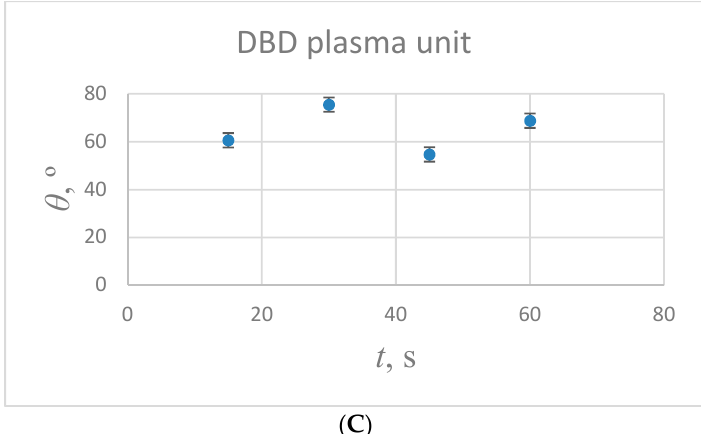
Figure 4. Impact of the dependence of the equilibrium apparent contact angle at the time of plasma treatment is presented. ( A ) Treatment with the Corona plasma discharge. ( B ) Treatment with the radiofrequency plasma device. ( C ) Treatment with the dielectric barrier (DBD) plasma unit.